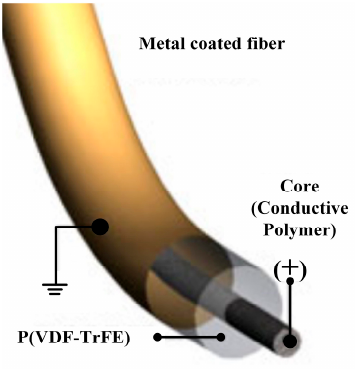
Figure 6. Schematic illustration of the configuration of the three-dimensional (3D) flexible piezoelectric sensor